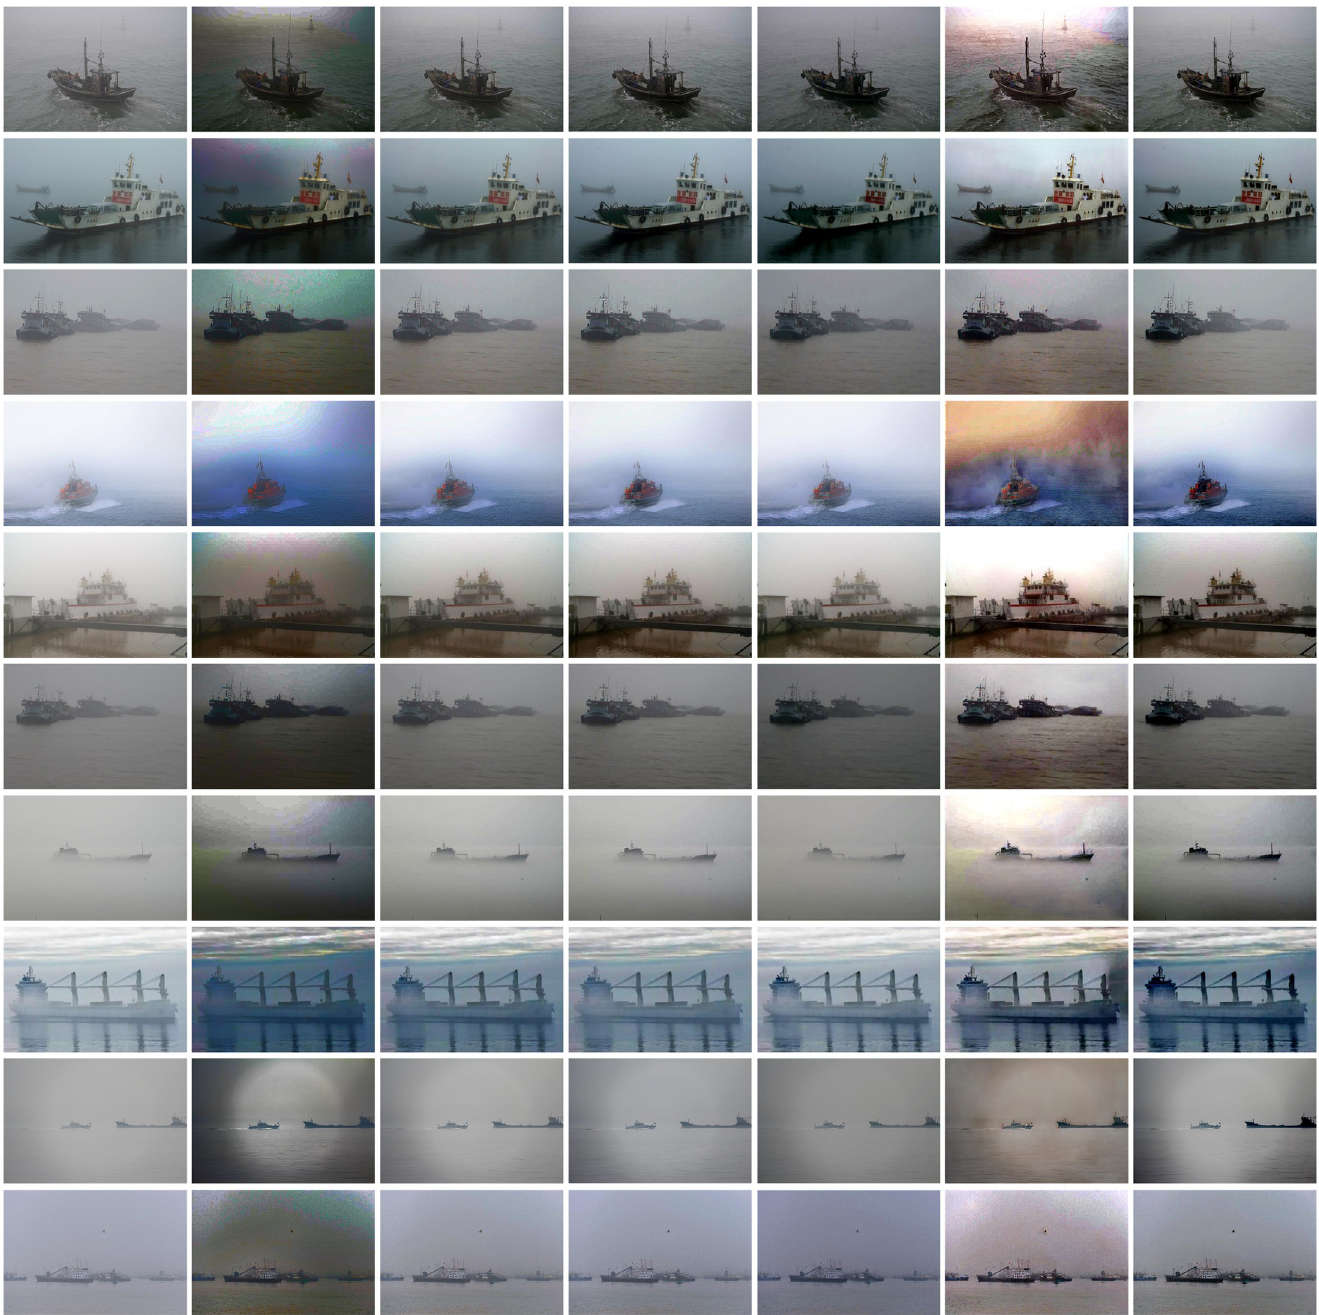
Fig 8. Quantitative comparison of different methods on real-world images. From the left to the right column (i.e., Fig 8(a)–8(g)), the input hazy image, DCP [1], CAP [2], DehazNet [4], AOD-Net [5], GCAN [10], and our result).